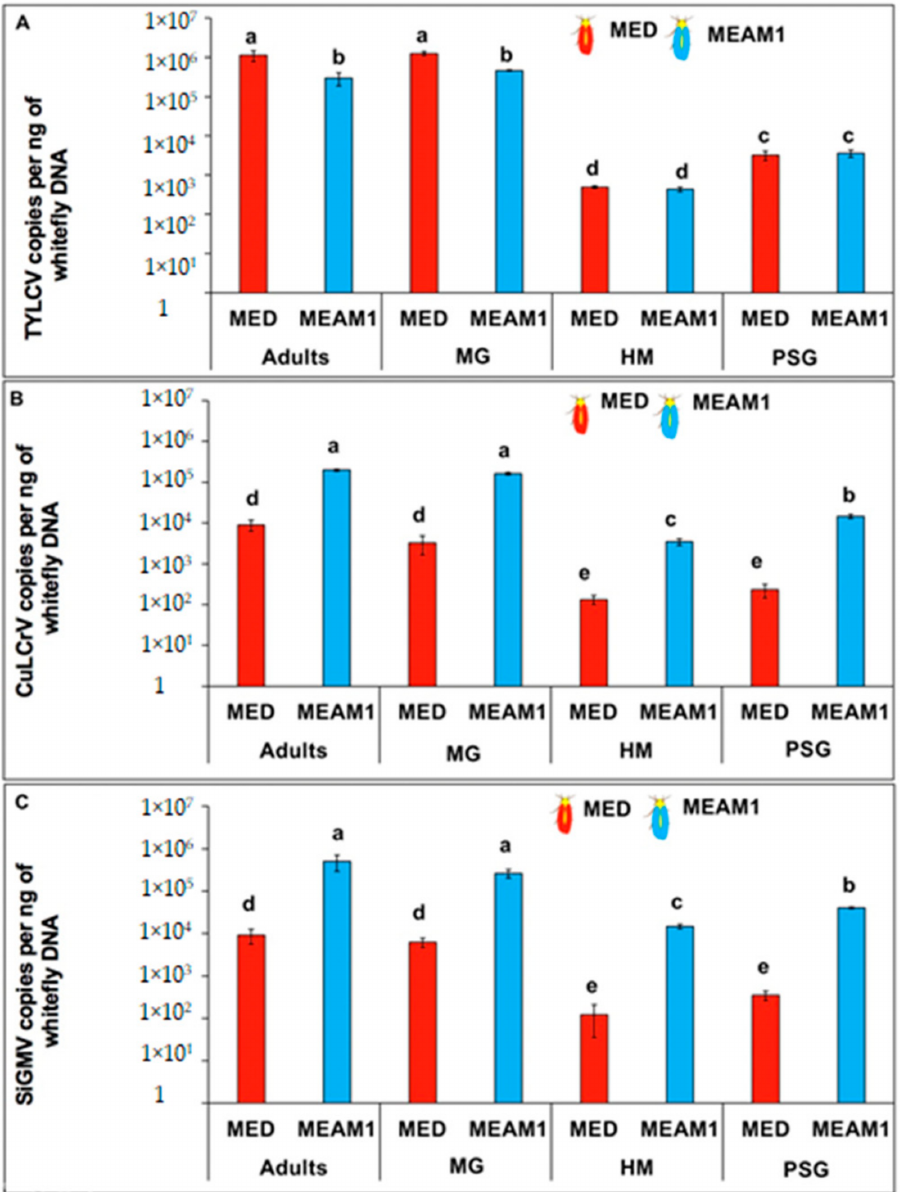
Figure 5. Virus accumulation in B. tabaci adults and tissues. Bars with standard errors represent mean virus copy numbers per ng of total DNA within whole adults, midguts (MG), hemolymph (HM), and primary salivary glands (PSG) of B. tabaci MEAM1 and B. tabaci MED adults following a 72 h AAP on ( A ) TYLCV-infected tomato plants, ( B ) CuLCrV-infected squash plants, or ( C ) SiGMV-infected prickly sida plants after a 72 h gut clearing. Y-axis is represented in a logarithmic scale and significant differences between means were analyzed using Tukey’s test at α =